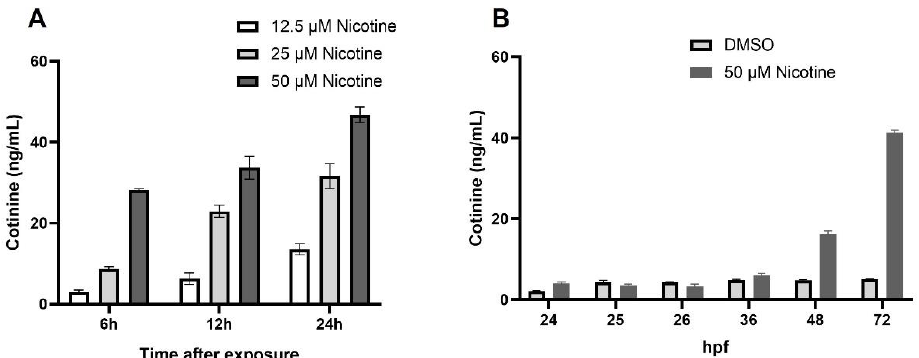
Figure 1. Cotinine levels in zebrafish embryo increases with the time of exposure. ( A ) Cotinine levels in zebrafish larvae exposed to different nicotine concentrations beginning at 4 dpf. ( B ) Cotinine levels in embryos exposed to 50 µM nicotine from 6 to 72 hpf.